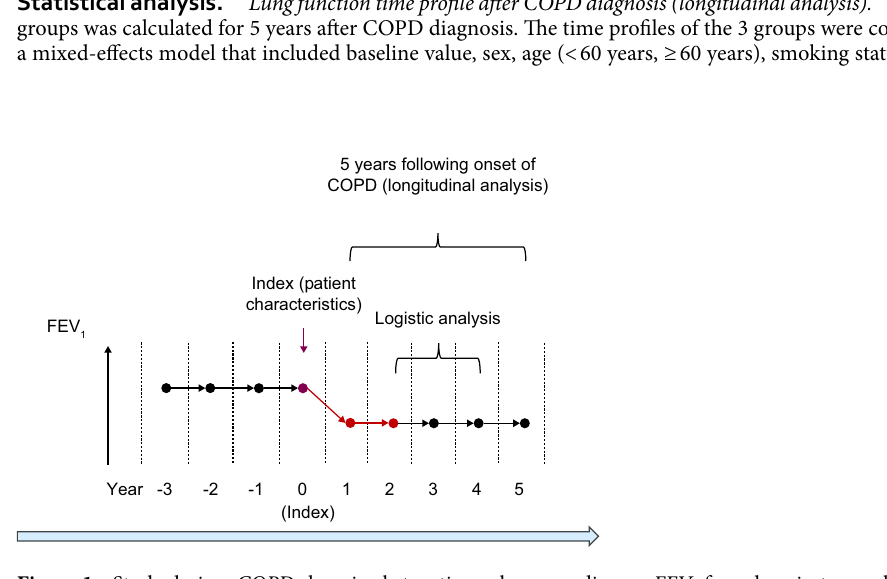
Figure 1. Study design. COPD chronic obstructive pulmonary disease, FEV 1 forced expiratory volume in 1